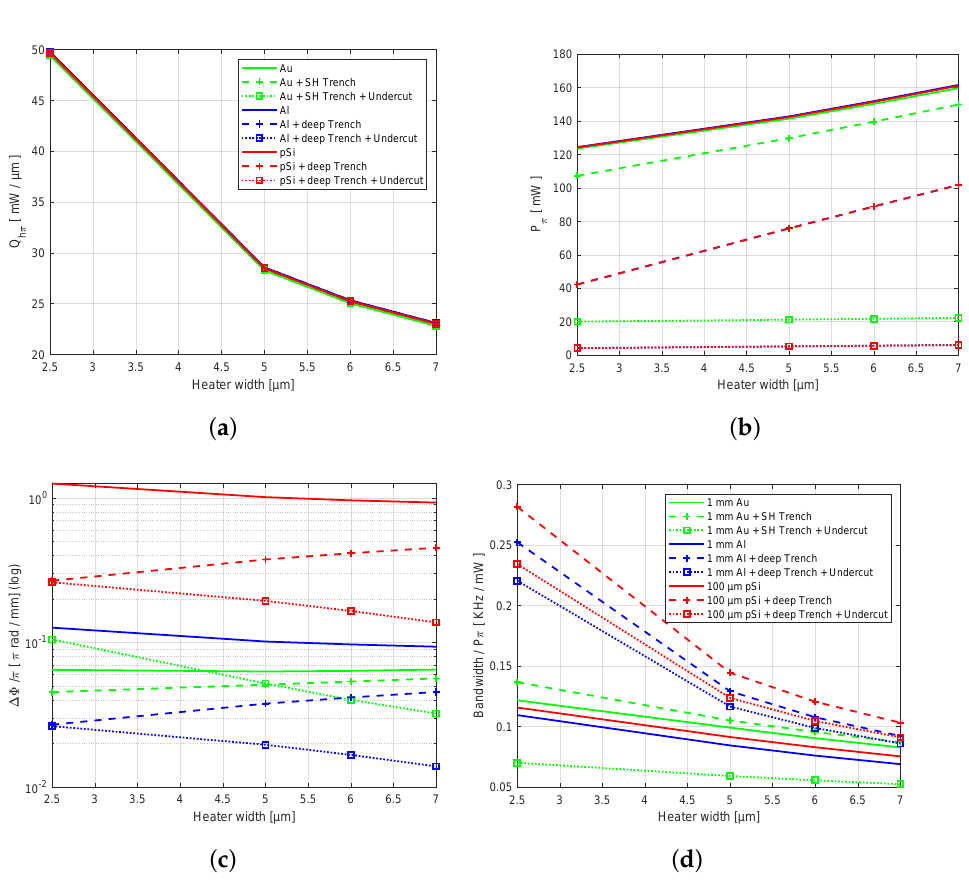
Figure 5. Simulation results for TO phase shifter designs at ∆Φ π considering h tr = 4.8 µ m, w tr = 7 µ m, o tr = 2 µ m, l h = 1 mm, w h = 7 µ m. Heat flux per heater unit length ( a ), power to shift π ( b ), crosstalk phase shift per heater unit length ( c ), and BW/ P π ( d ). Note that in panel ( b ) the curves for Al and poly-Si appear always